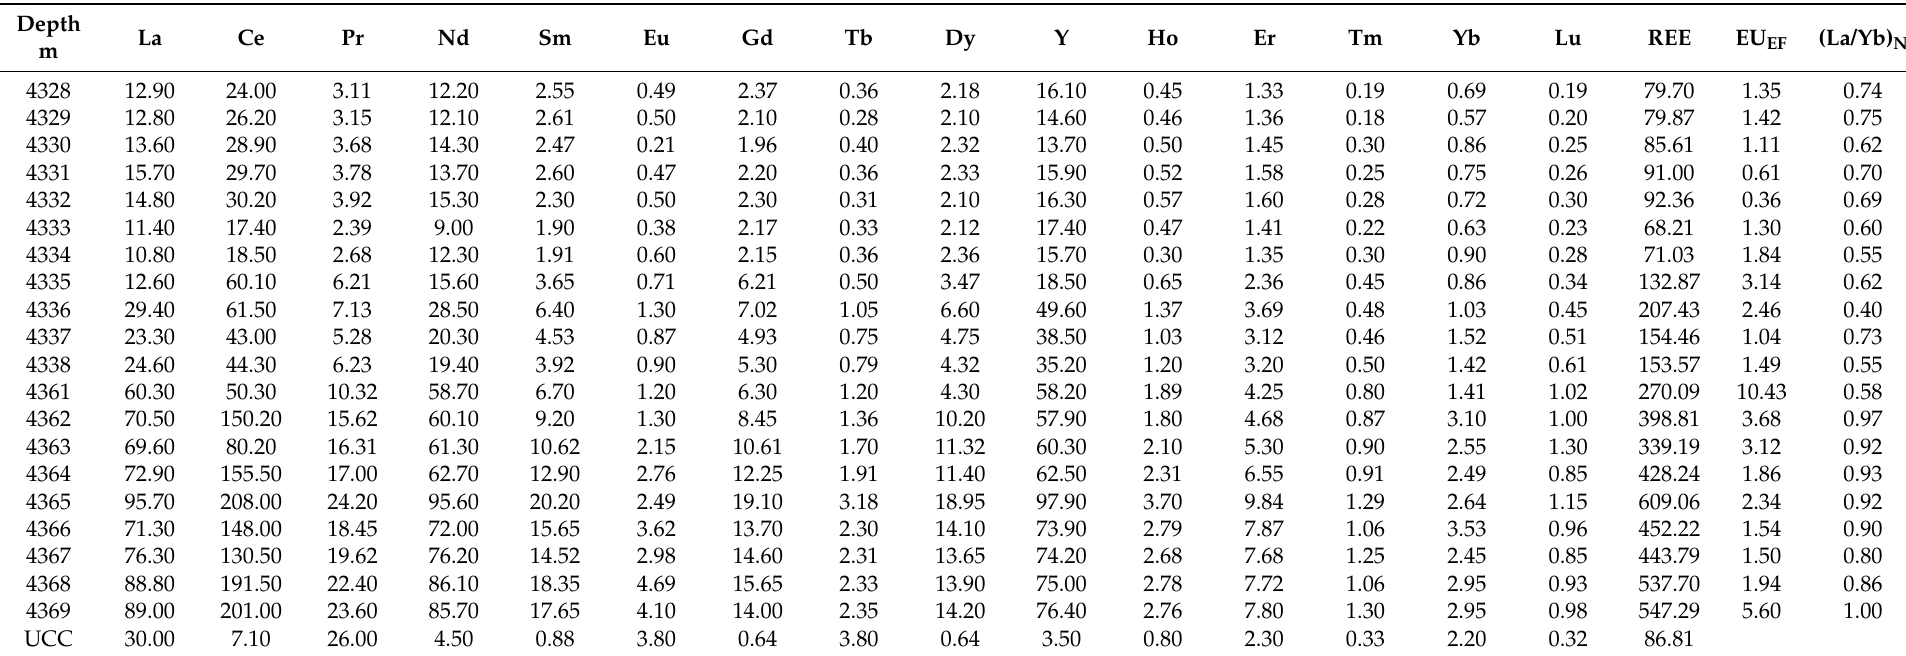
Table 2. Rare earth element contents and their correlation parameters (ug/g) of the shales of the Wujiaping Formation (UCC quoted from